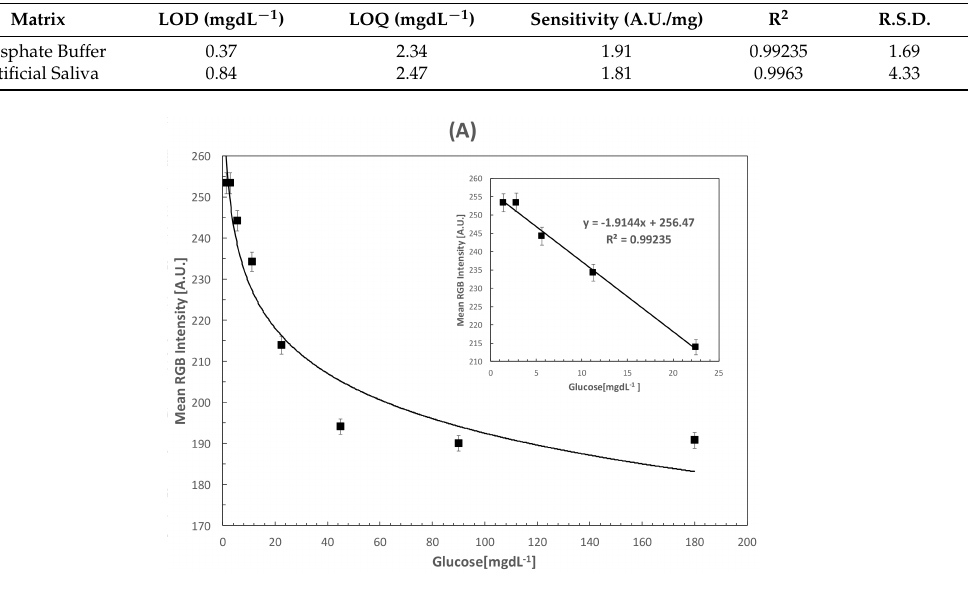
Table 1. Analytical figures of merit for the developed paper-based biosensor.